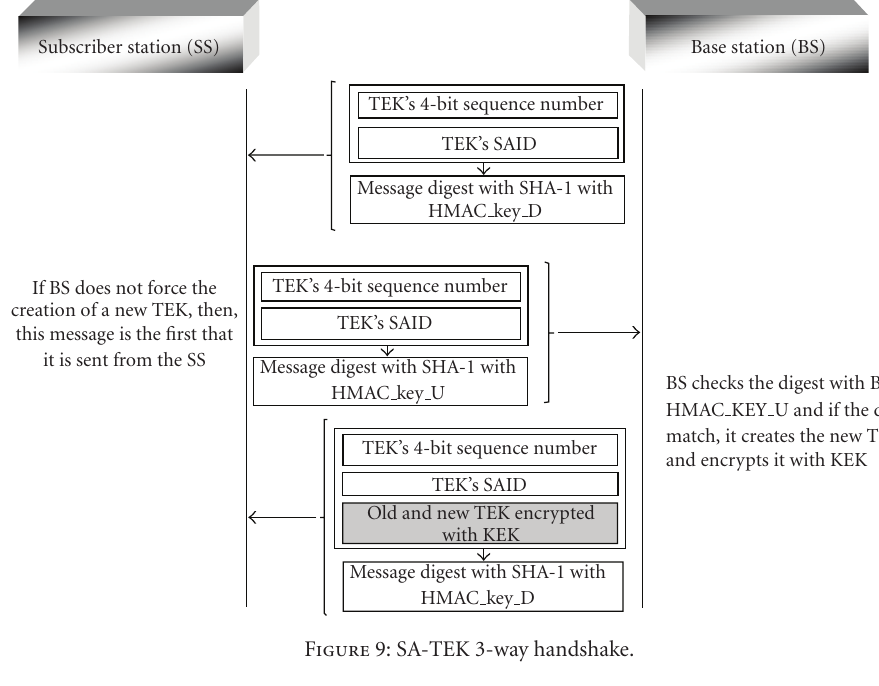
Figure 9: SA-TEK 3-way handshake.